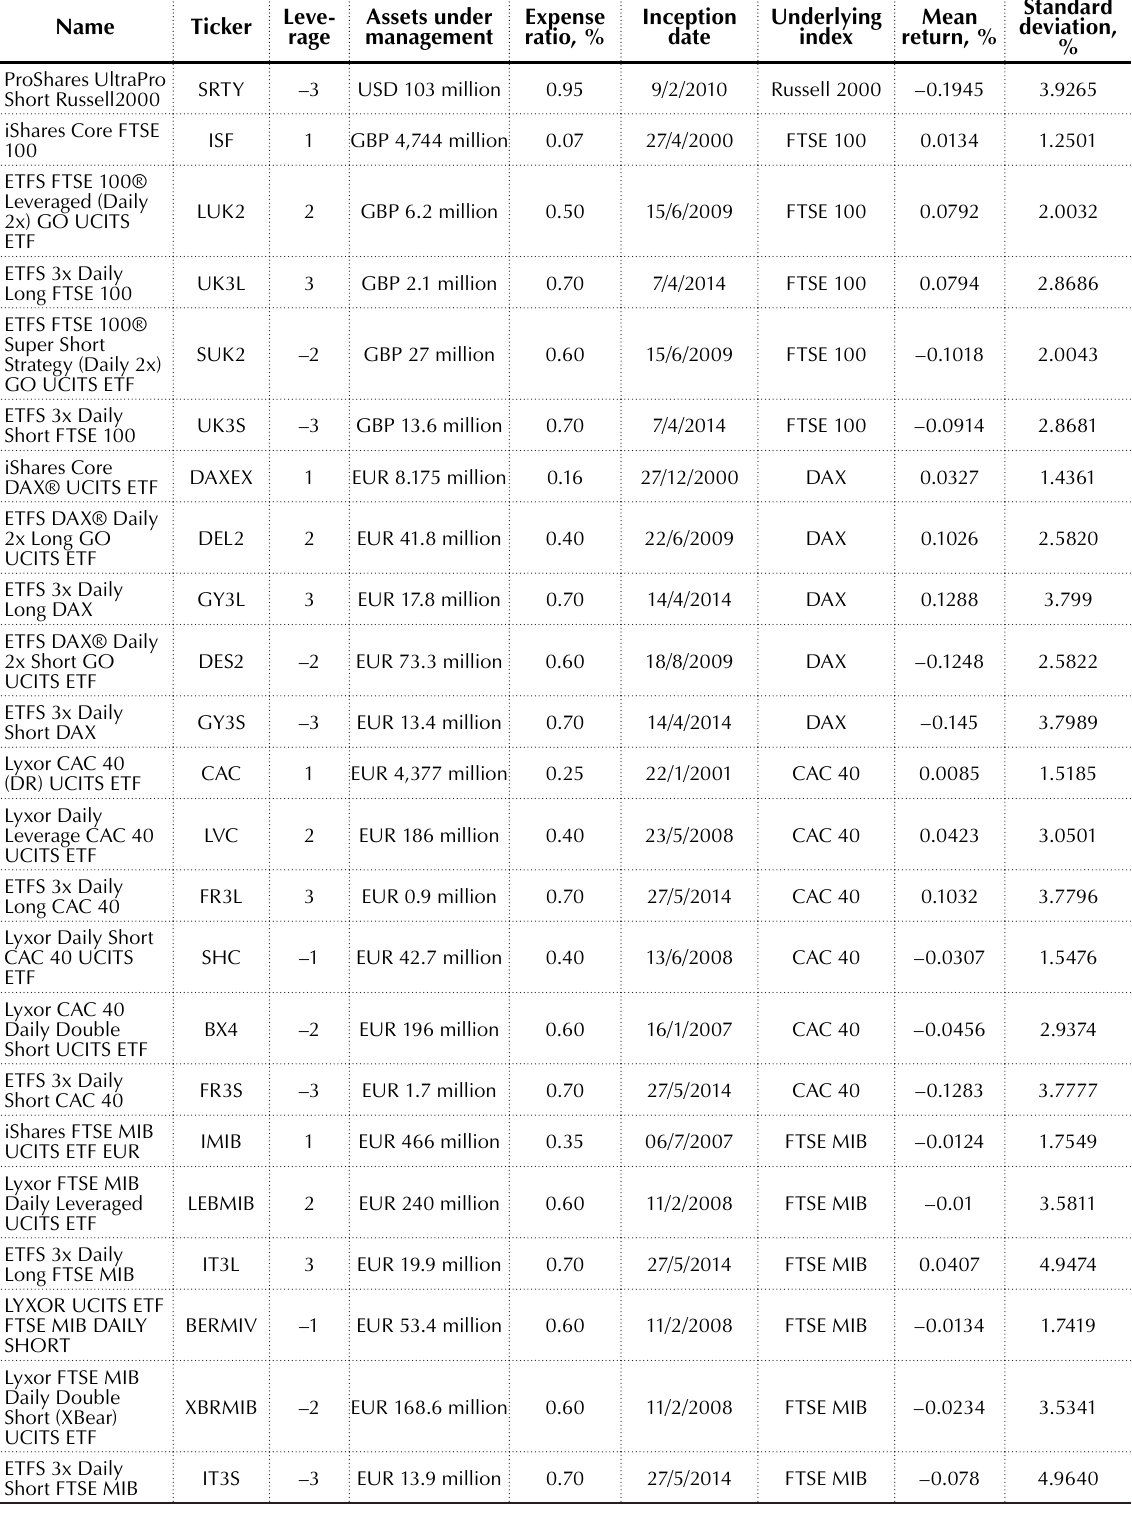
Table 3 (cont.). ETF characteristics and descriptive